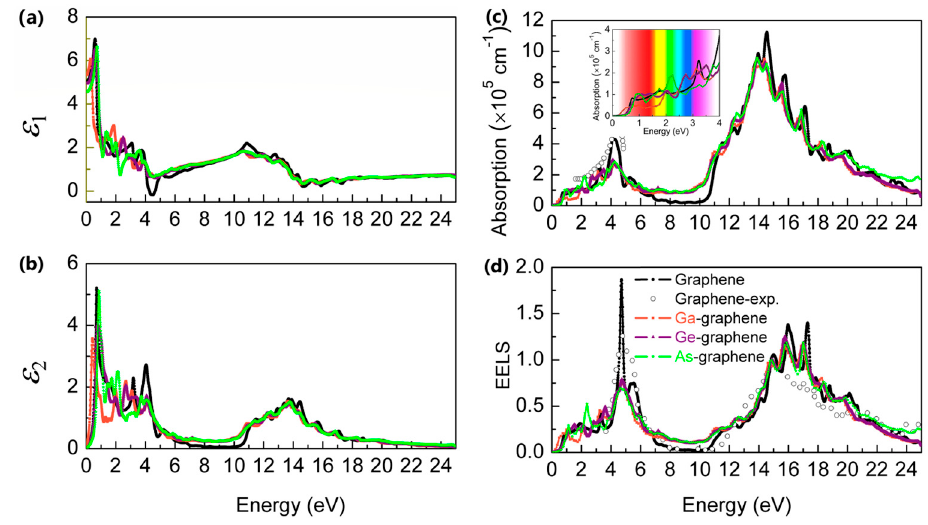
Figure 7. The optical properties of pristine and ion-implanted graphene. ( a ) The imaginary part and ( b ) the real part of the dielectric function. ( c ) The optical absorption coefficient. ( d ) The electron energy-loss spectrum. The experimental data of pristine graphene are taken from Nair [41] and Eberlein [42], respectively.